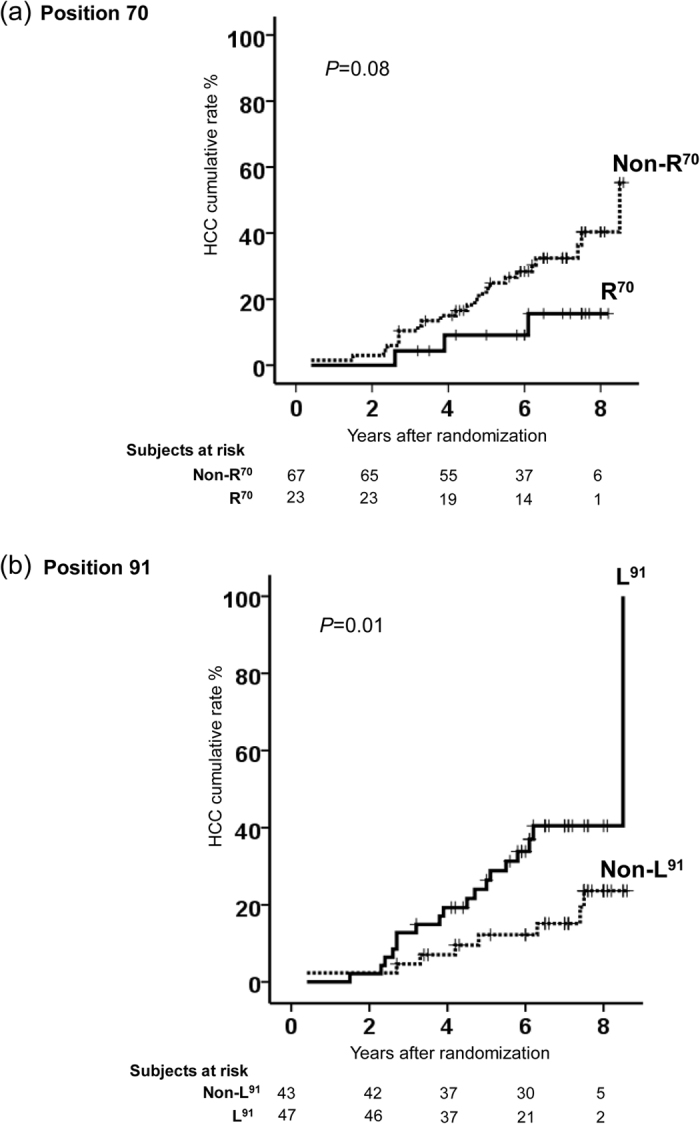
Kaplan-Meier analysis of the cumulative HCC incidence rate based on the frequency of quasispecies at postions 70 (a) and 91 (b) of the core protein. Cut-points at ≥42% for core-non-R70 and at ≥98.5% for core-non-L91 were used in this analysis.